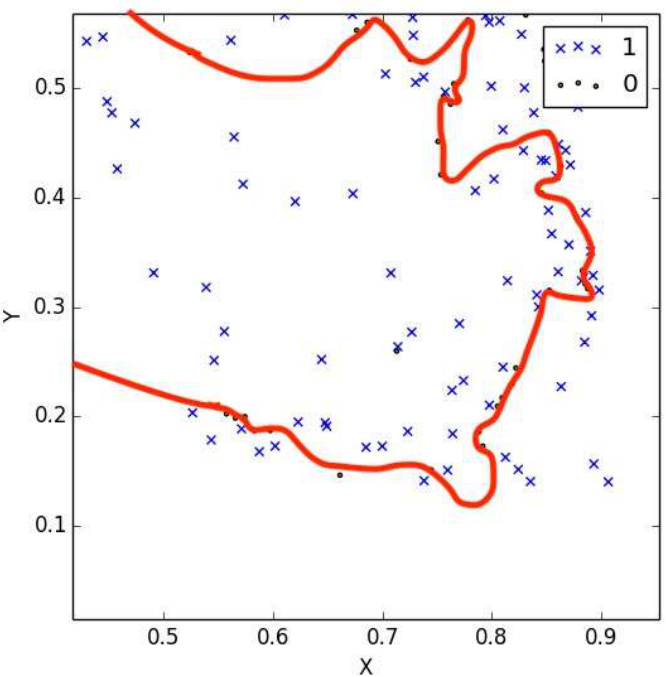
Figure 10. The decision surface (solid line) obtained from the attack when the attractor is the same as from Figure 1 and enough observations are known.